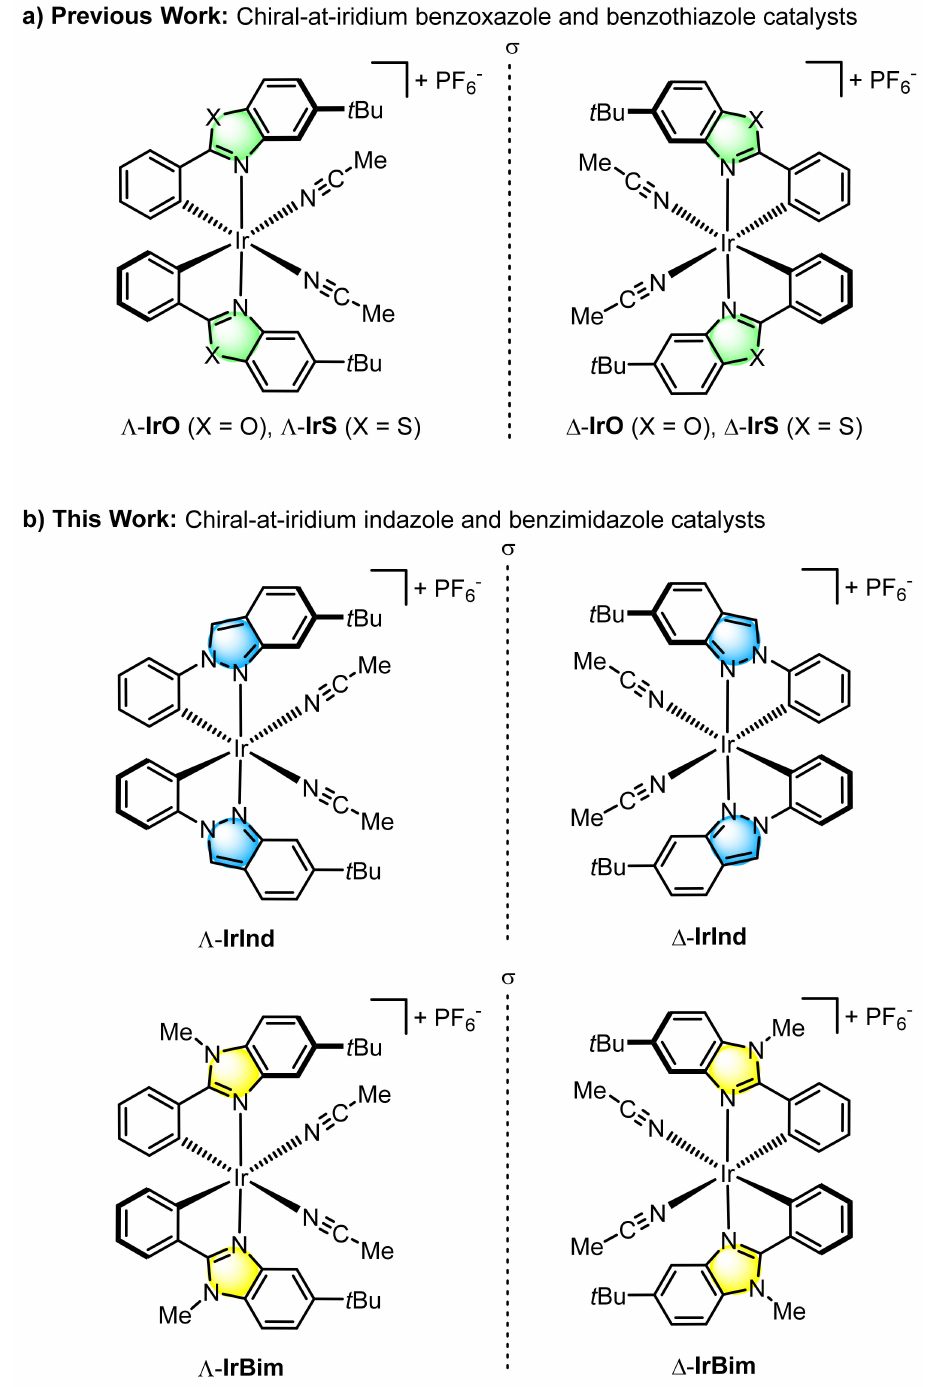
Figure 1. Bis-cyclometalated chiral-at-iridium catalysts for asymmetric conversions. ( a ) Our most successful previous design. ( b ) This